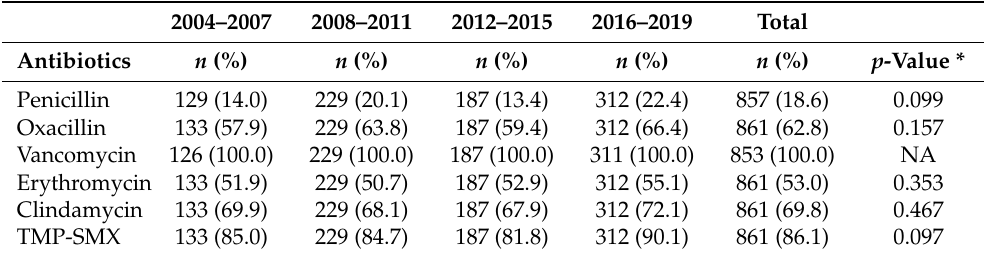
Table 7. Susceptibility of Staphylococci isolates to the tested